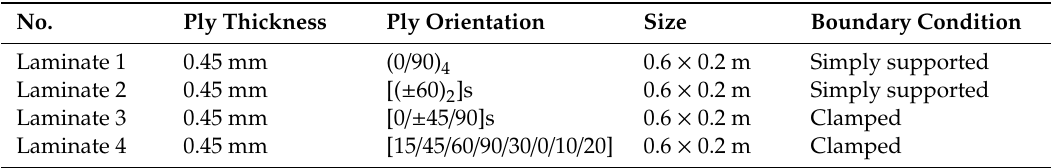
Table 3. Laminate plate